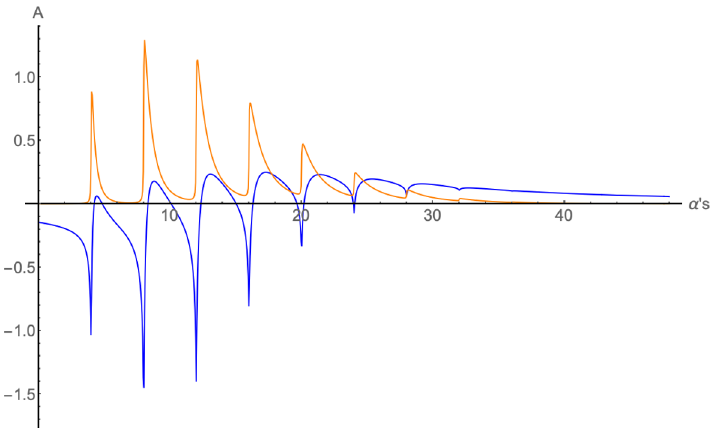
Figure 6 . Real and imaginary parts of the amplitude computed in Witten’s model. The parameters here are cos θ = 0 . 8 , (cid:15) = 0 . 005